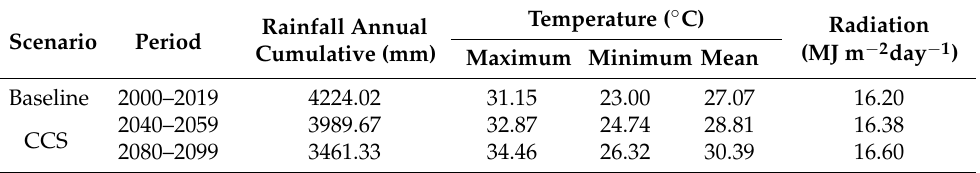
Table 2. Comparison of climatological variables for each scenario.